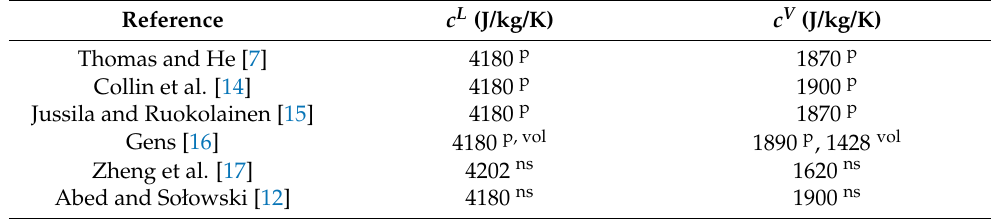
Table 2. Specific heat capacity of water in liquid and vapour forms given in the literature for modelling unsaturated soils and clay-based engineered barriers.